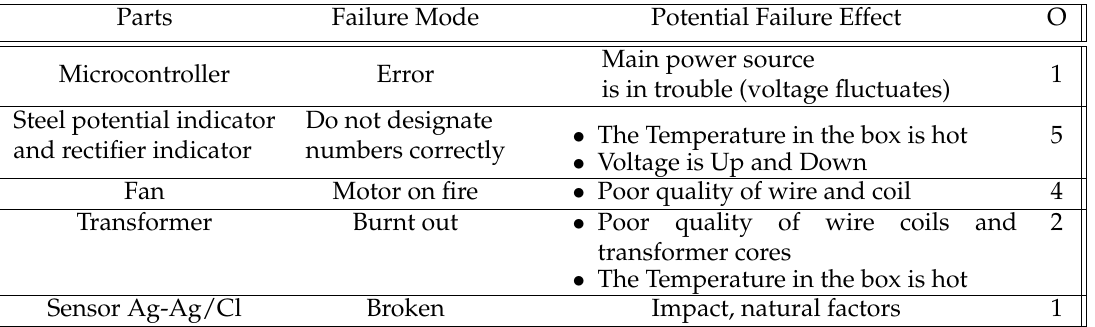
Table 3. Result of Occurrence scores for Failure in ICCP.